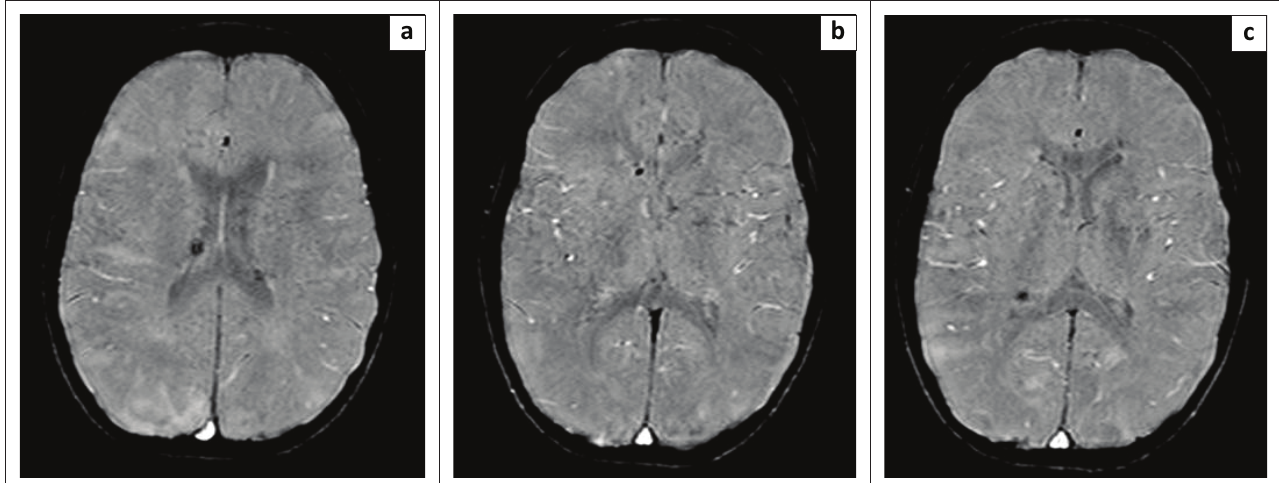
FIGURE 10: Susceptibility-weighted imaging sequence images showing multiple and more obvious calcified subependymal nodules (a, b and c).